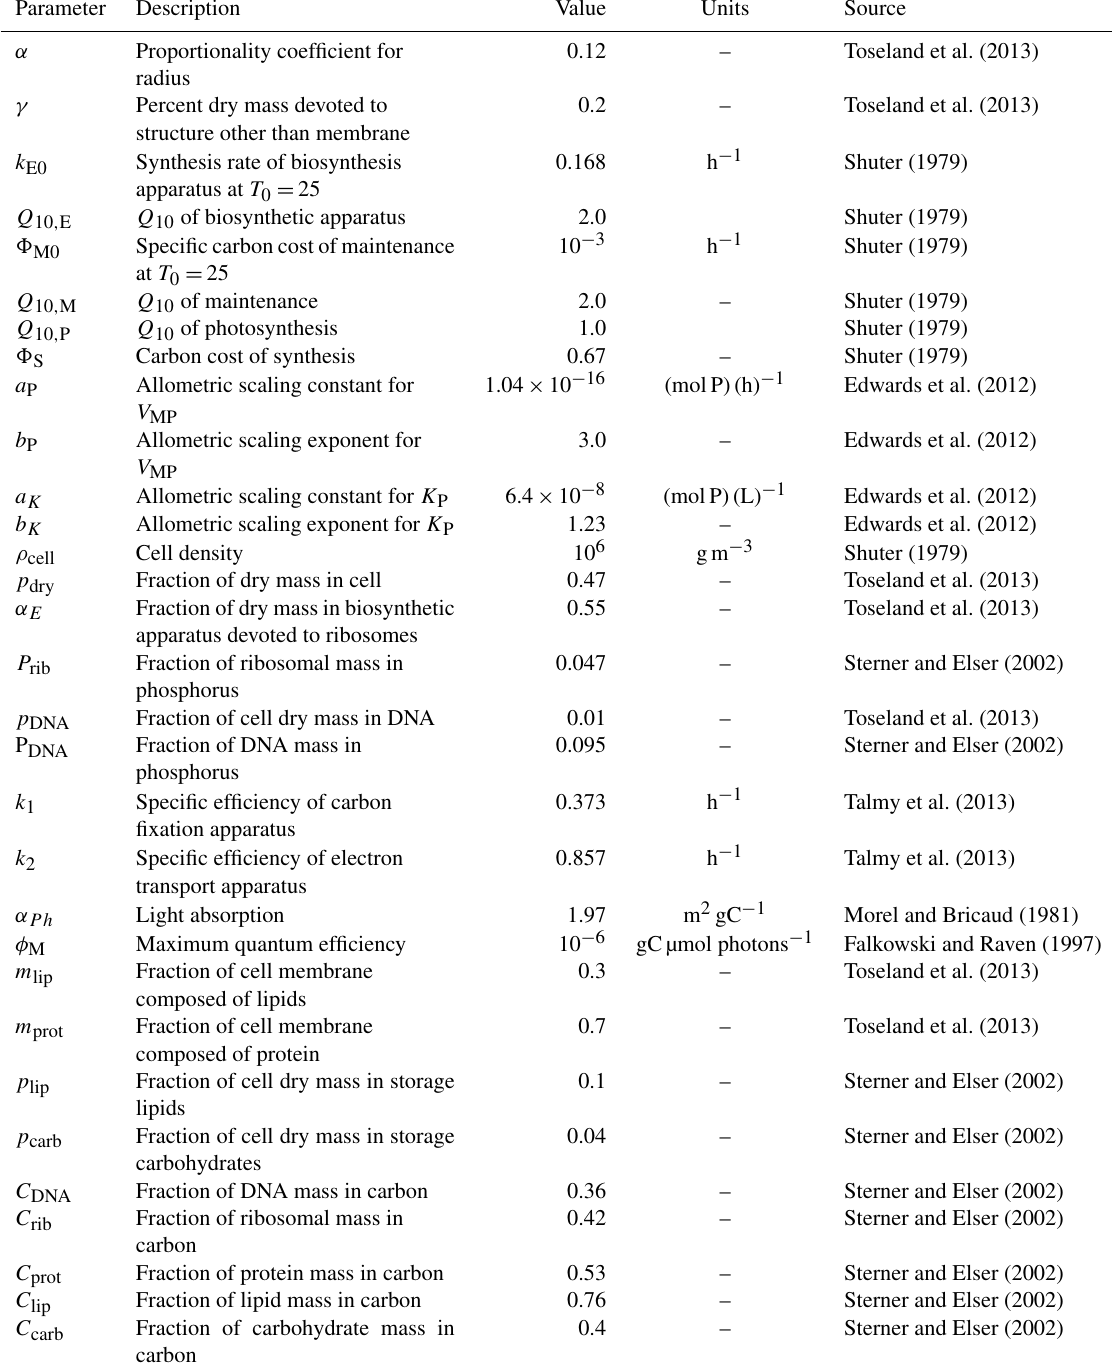
Table 2. Physiological model